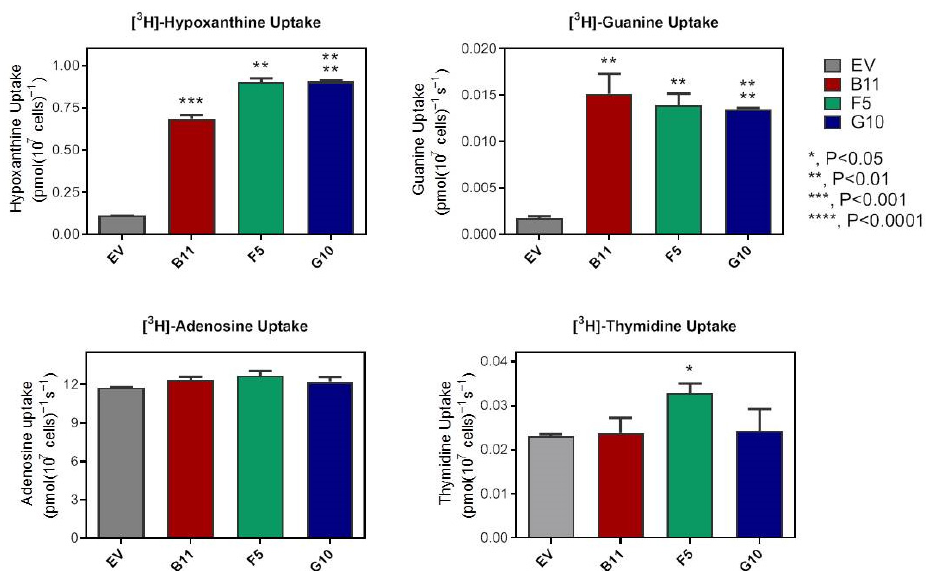
Figure 2. Uptake of radiolabelled nucleosides and nucleobases by in three clonal lines of T. brucei NB- KO procyclics, expressing Tg244440 in pHD1336. EV, empty vector control. Radiolabel concentration was 0.1 µ M and uptake was measured over 60 s, in triplicate (average and SEM shown). Statistically significant differences between the control and the Tg244440-expressing cells were established using Student’s unpaired t ‐ test. *, p <0.05, **, p <0.01, ***, p <0.001.